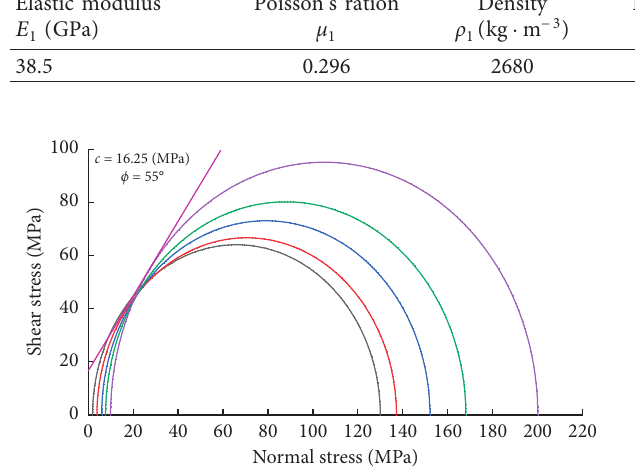
Figure 5: Compressive strength parameters of limestone rock samples in natural state.